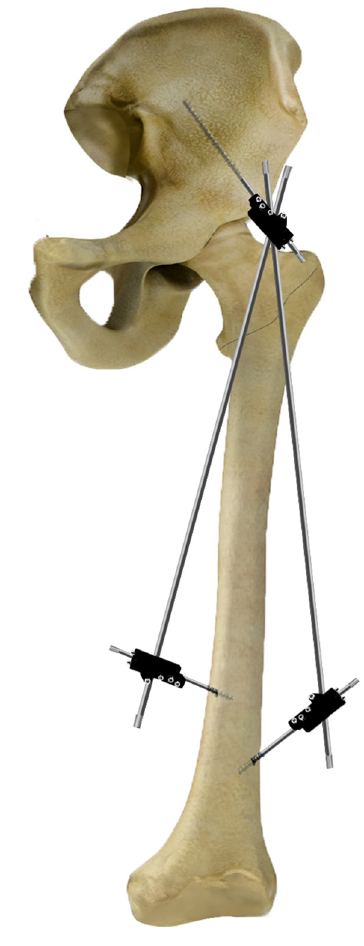
Figure 1: It illustrates the details of this novel external fi xation method via the AIIS and distal